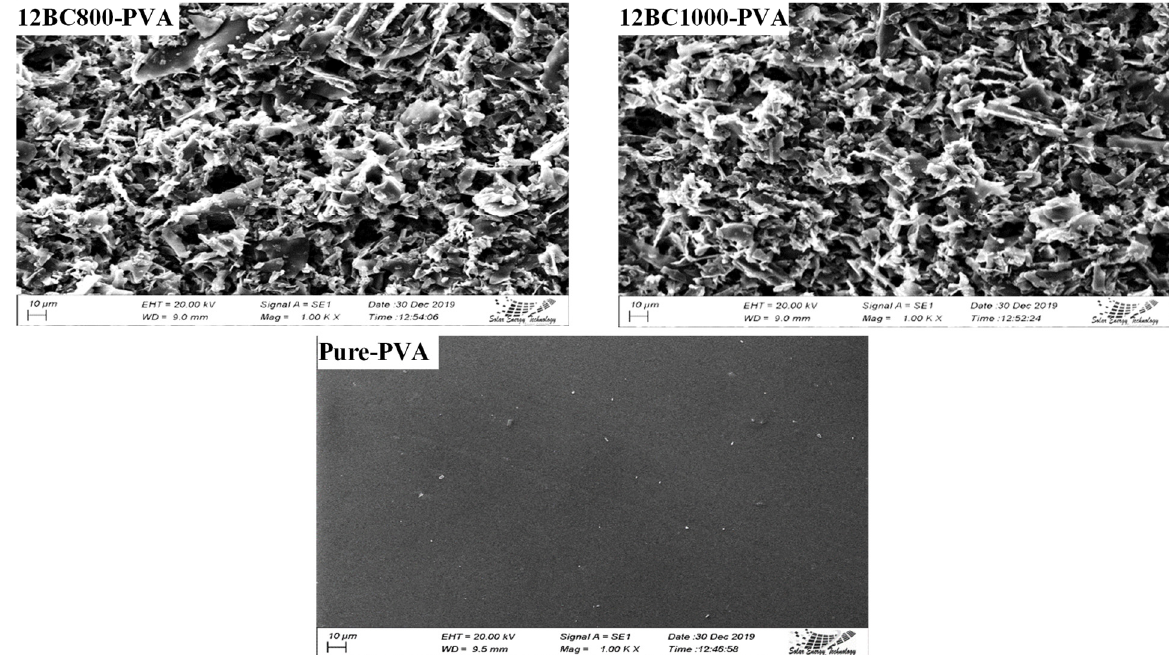
Figure 5. Surface characteristics of the biochar reinforced biocomposite films.